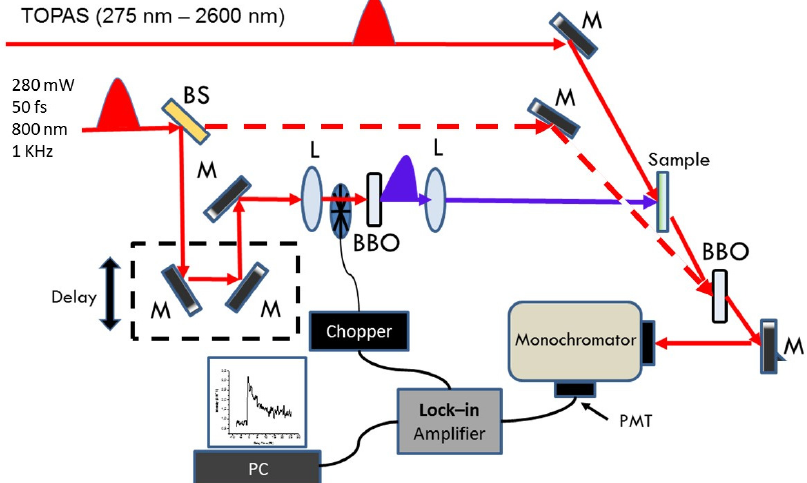
Figure 6. Experimental setup for ultrafast two color transient absorption